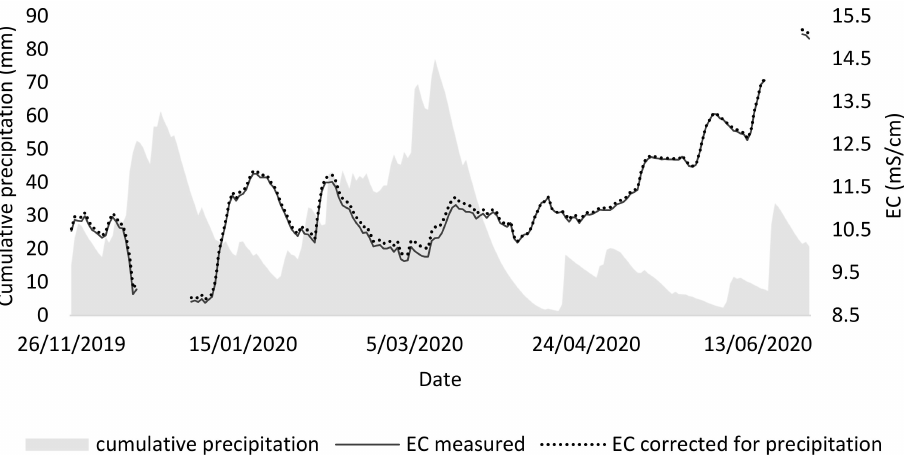
Figure 6. Electric conductivity (EC) measured in the aerobic tank (last tank) of a biological pig manure treatment system, together with the cumulative precipitation that could enter the system over a retention time of 36 days. Additionally, a corrected EC was calculated for the dilution from